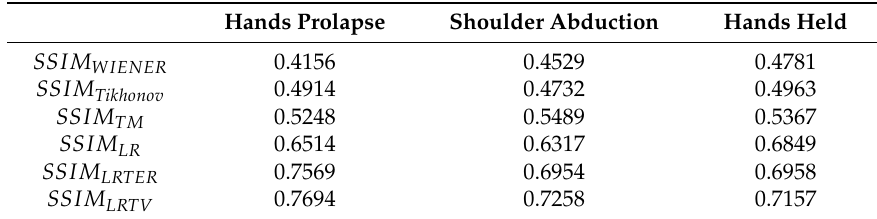
Table 6. The SSIM with different algorithms in real data